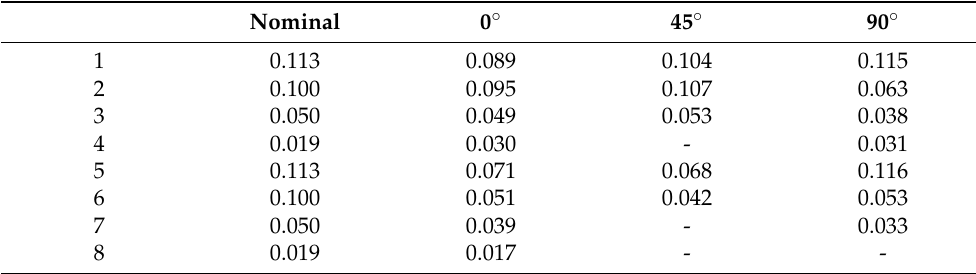
Table 5. Volume of morphological features